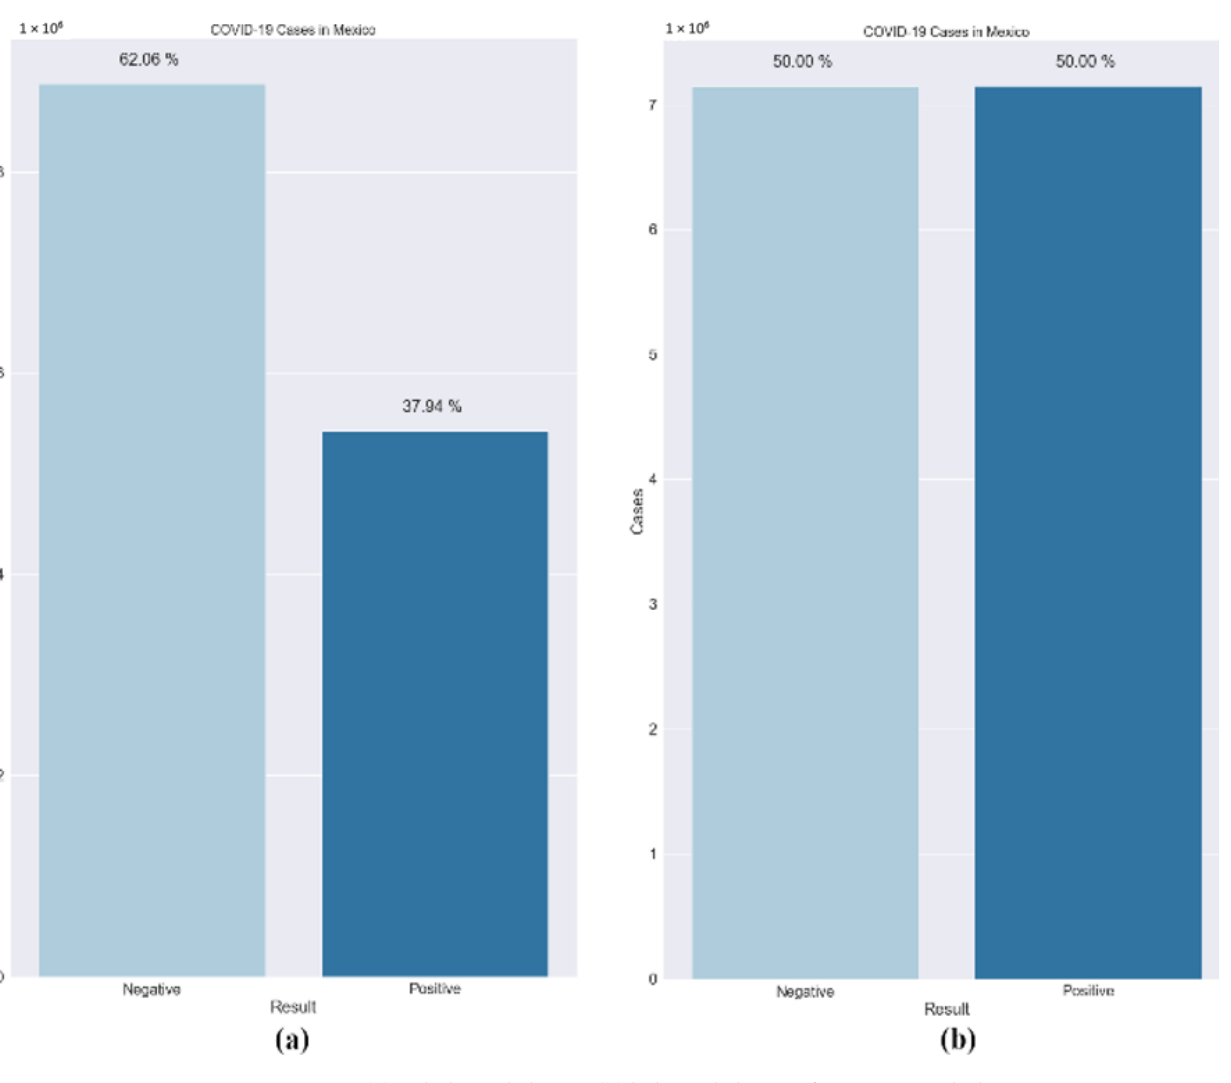
Figure 5. ( a ) Imbalanced classes, ( b ) balanced classes after using